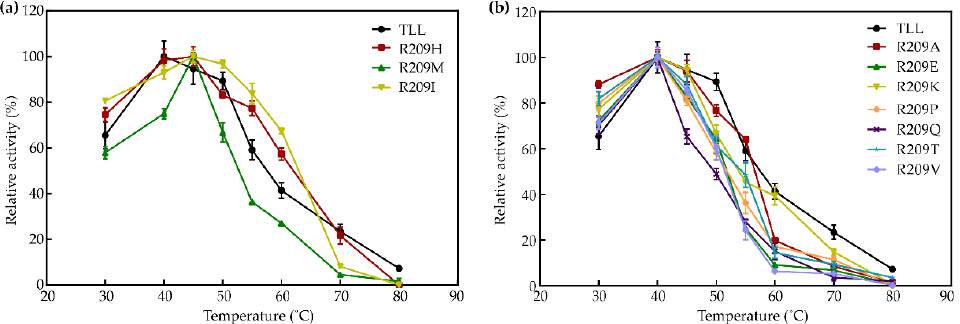
Figure 2. Optimal reaction temperature of TLL and ten R209 mutants. ( a ) R209 mutants with increased optimal reaction temperature; ( b ) R209 mutants revealed with the same optimal reaction temperature.